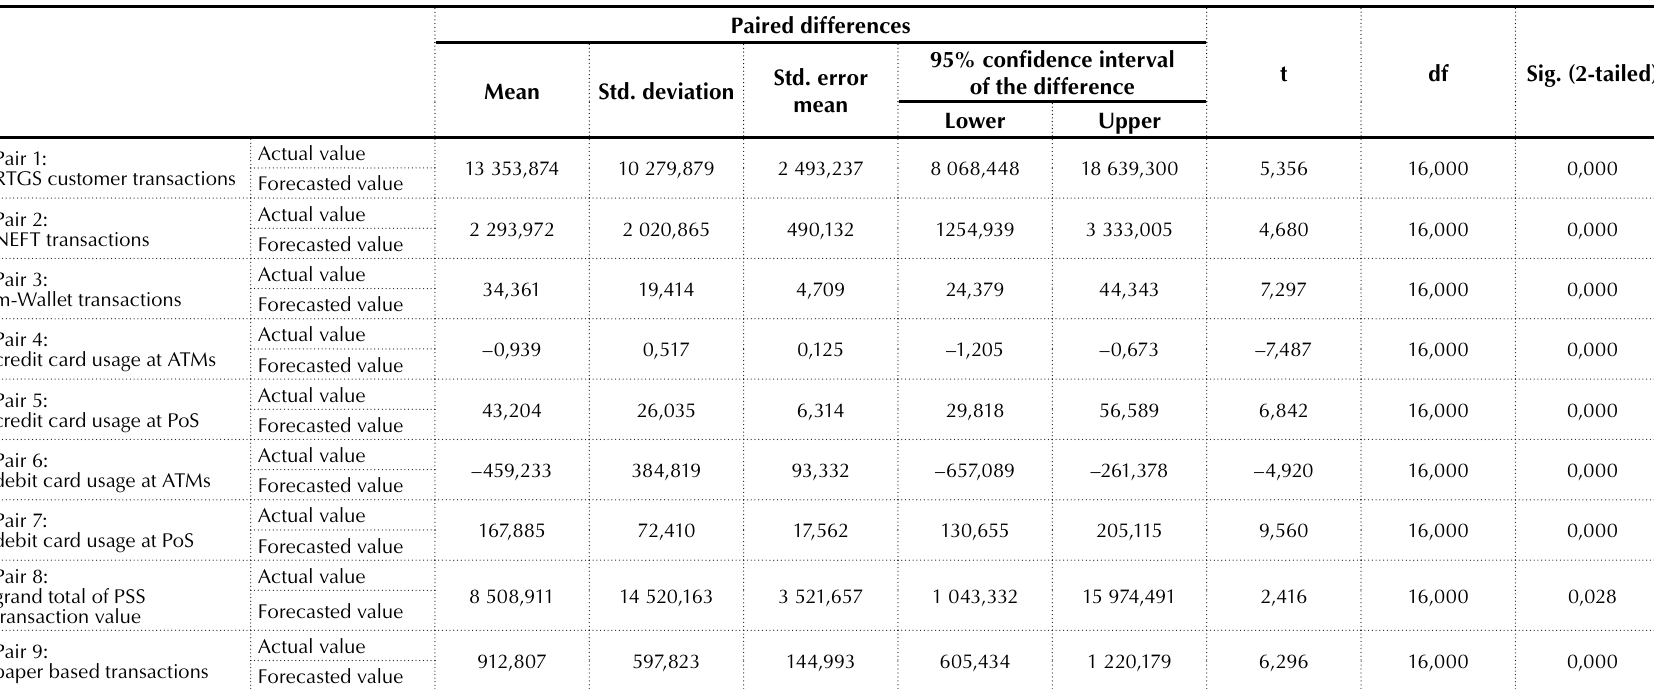
Table 3. Results of paired t-test for the difference between actual and forecasted value of transactions in the selected indicators